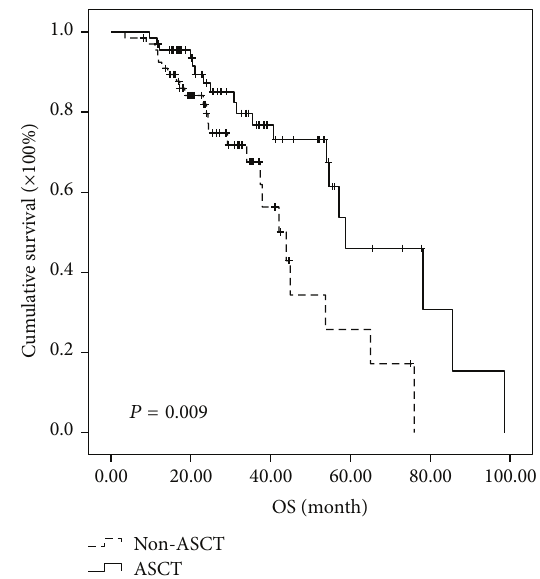
Figure 2: Comparison of OS in the patients of ASCT group and non-ASCT group regardless of risk stratification. The median OS was prolonged 16.7 months in ASCT group (58.8 versus 42.1 months, 𝑃 = 0.009 ).